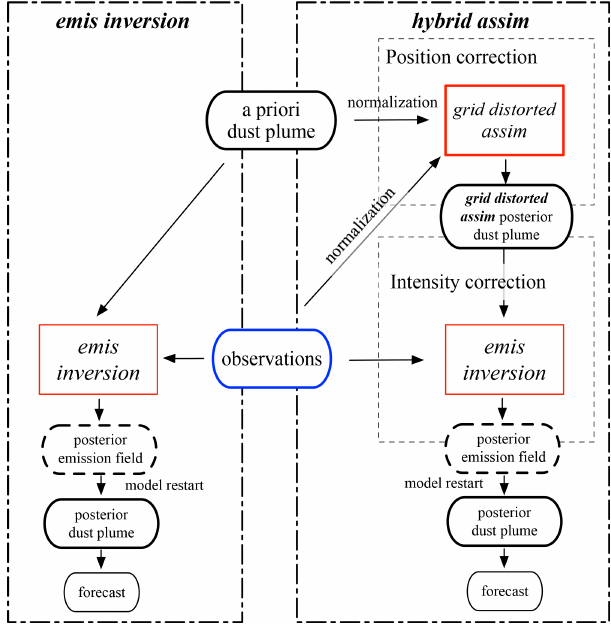
Figure 6. Diagrams of emis inversion, grid-distorted assim and hy- brid assim